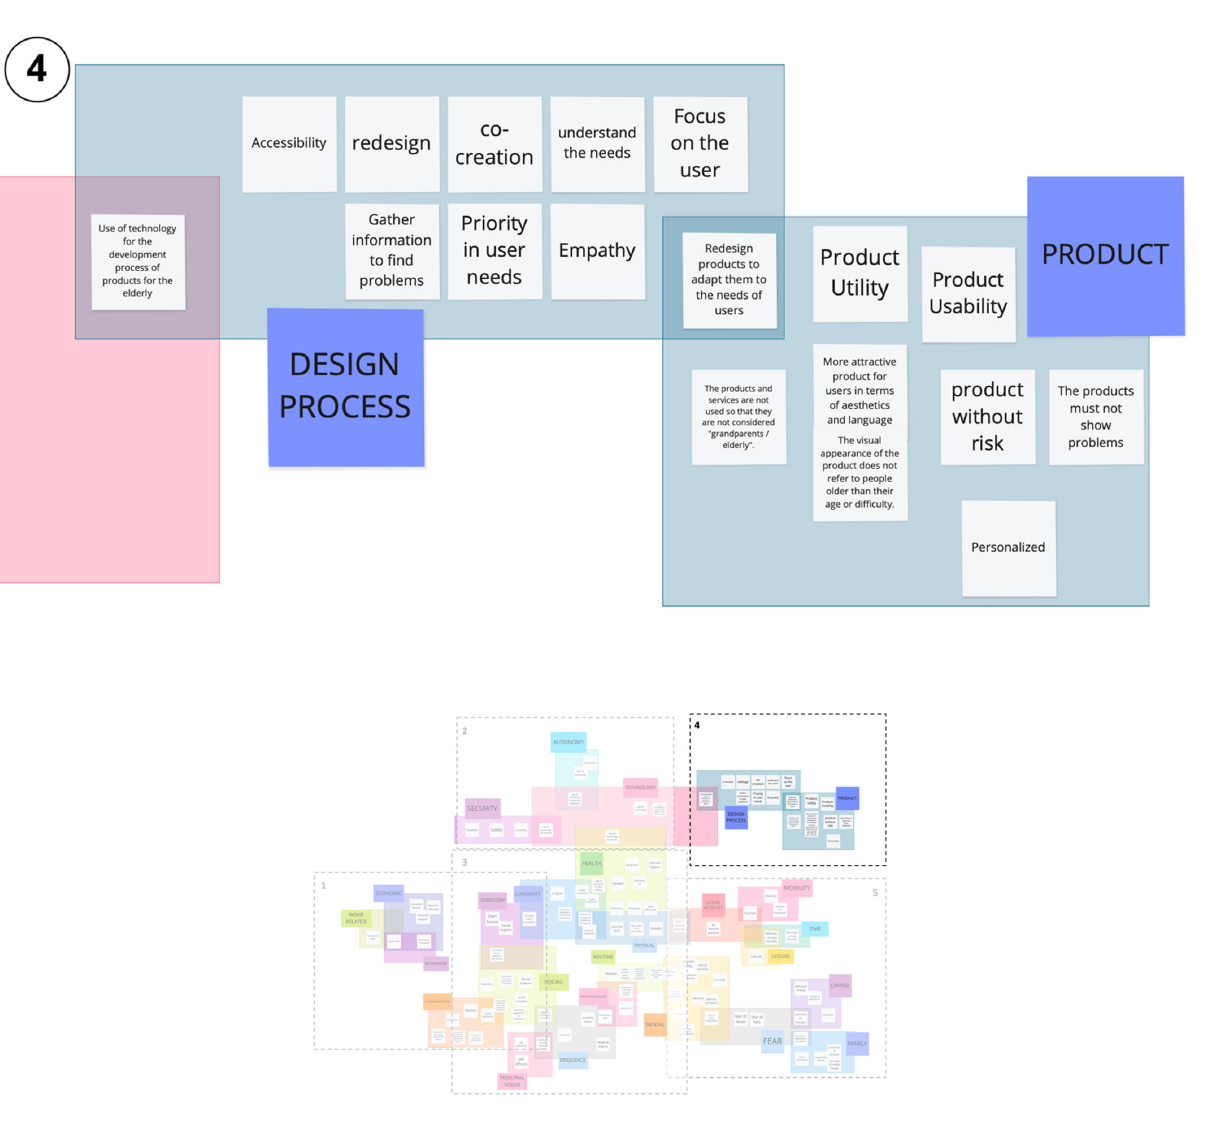
Figure A4. Map Section 4.